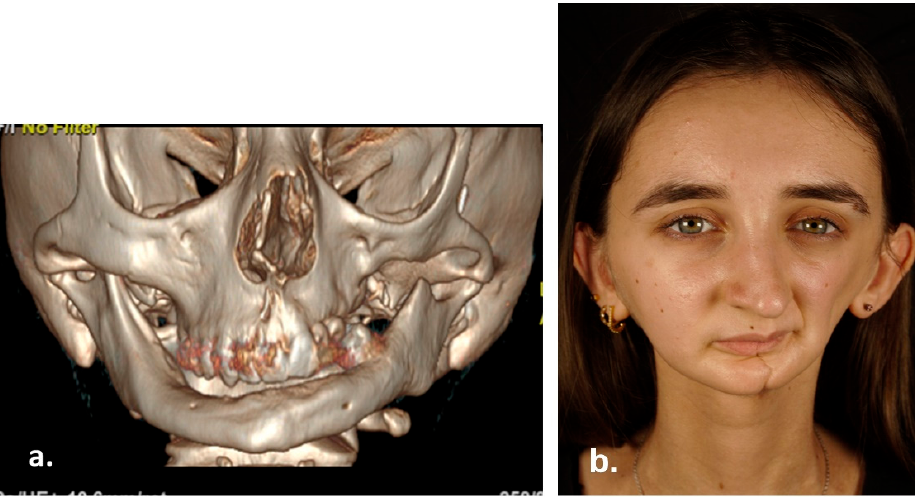
Figure 7. 3D Computed Tomography ( a ) and clinical appearance ( b ) 15 years after surgery.